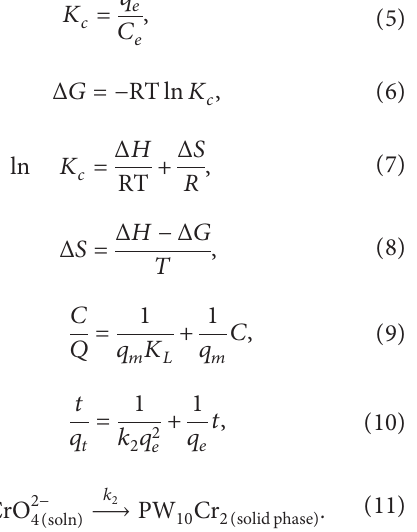
Figure 10: SEM images of (a) Fe 3 O 4 @SiO 2 and (b) Fe 3 O 4 @SiO 2 @ LEuH@PW 10 and (c) EDX metal mapping for W (all the scale bars are